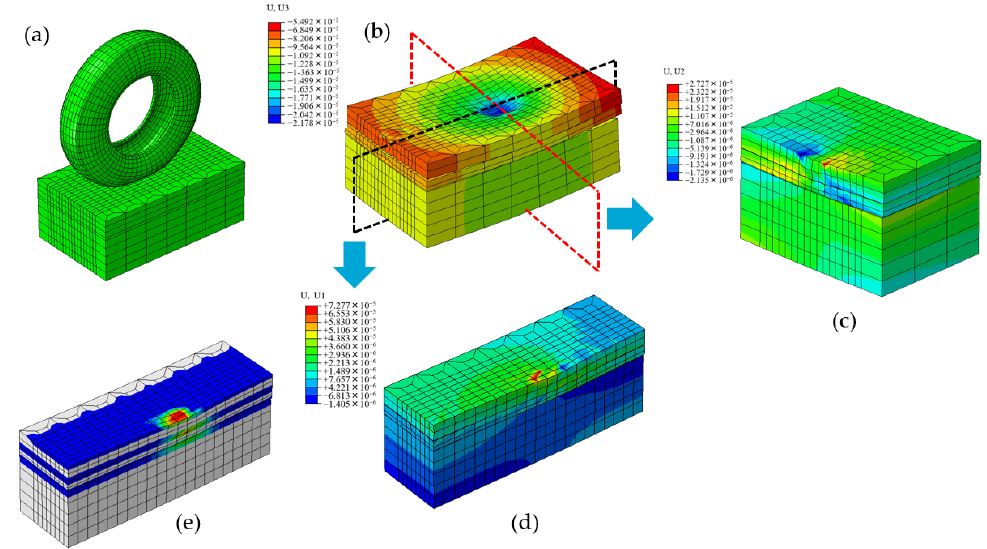
Figure 10. The dynamic responses of ART pavement at the speed of 10 km/h. (a) Tire-pavement contact area. (b) Vertical displacement. (c) Vertical displacement along the transverse. (d) Longitudinal displacement along the longitudinal profile. (e) Interlayer contact pressure.